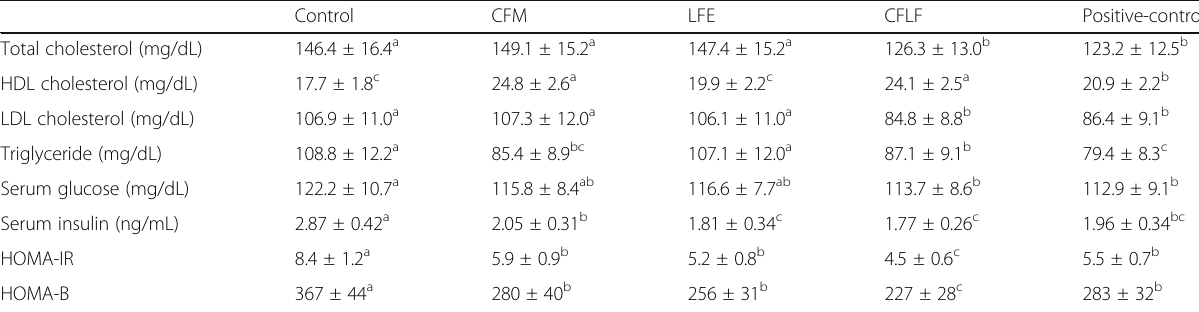
Table 3 Glucose and lipid metabolism in overnight-fasted states Control CFM LFE CFLF